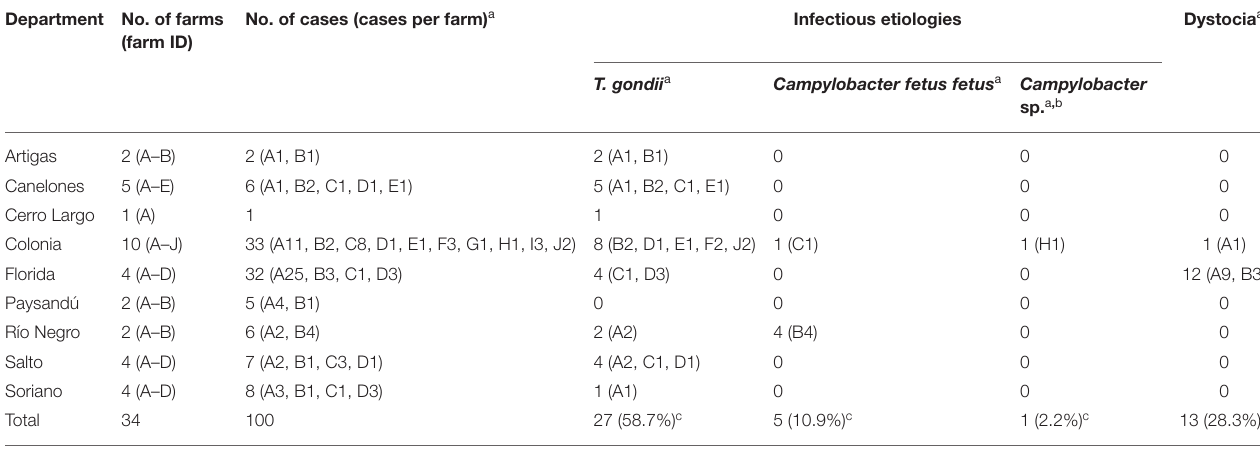
TABLE 2 | Geographic location of the farms, number of farms, number of analyzed cases, and identified etiologies in 100 cases of ovine abortion investigated during the 2015–2021 period. Department No. of farms (farm ID)